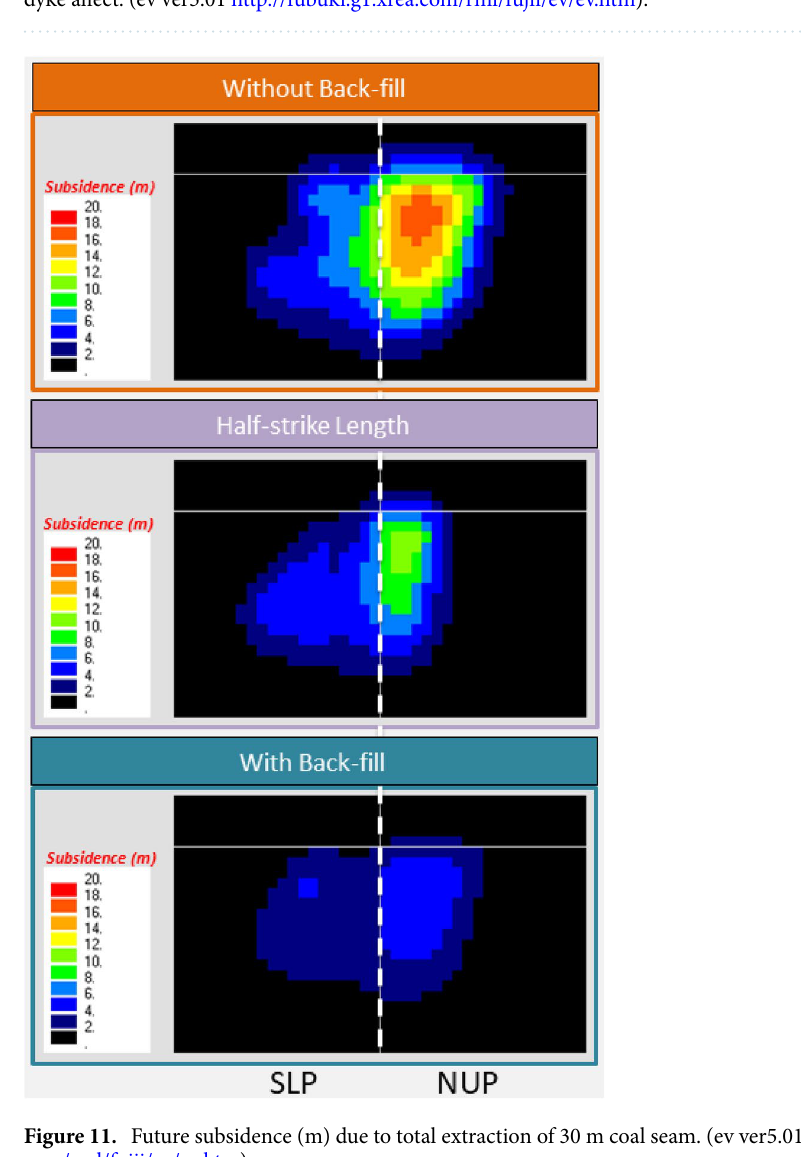
Figure 10. ( a ) The subsidence (m) due to panel extraction with faults and the dyke effect and ( b ) faults and the dyke affect. (ev ver5.01 http:// fubuki. g1. xrea. com/ rml/ fujii/ ev/ ev. htm).